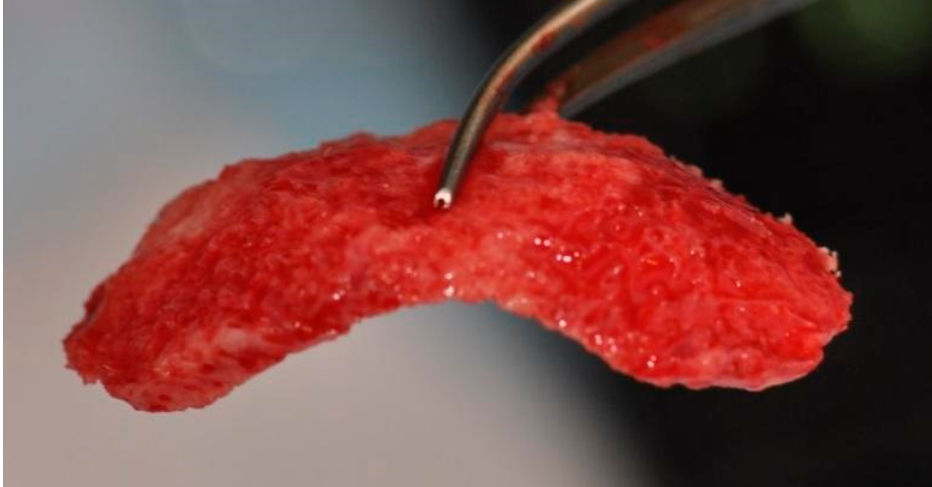
Figure 6. Individualized allogeneic bone block soaked in injectable platelet-rich fibrin before placement. In order to immobilize the bone block, and for its appropriate adaptation to the base, two 11 mm long resorbable polylactaic pins were ultrasonically introduced using the Son-